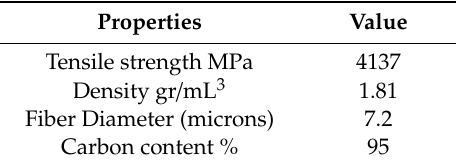
Table 5. The Properties of Fiber Reinforce Polymer